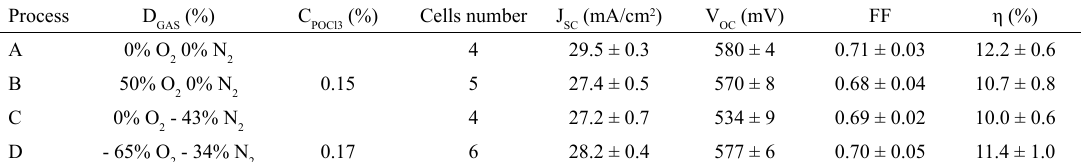
Table 5. Electrical characteristics of solar cells as function of oxygen and nitrogen flow variation (D in the quartz tube and Al diffusion, respectively, for aluminum and phosphorus diffusion temperature of 875 °C. The aluminum and phosphorus diffusion time was 90 and 70 minutes,